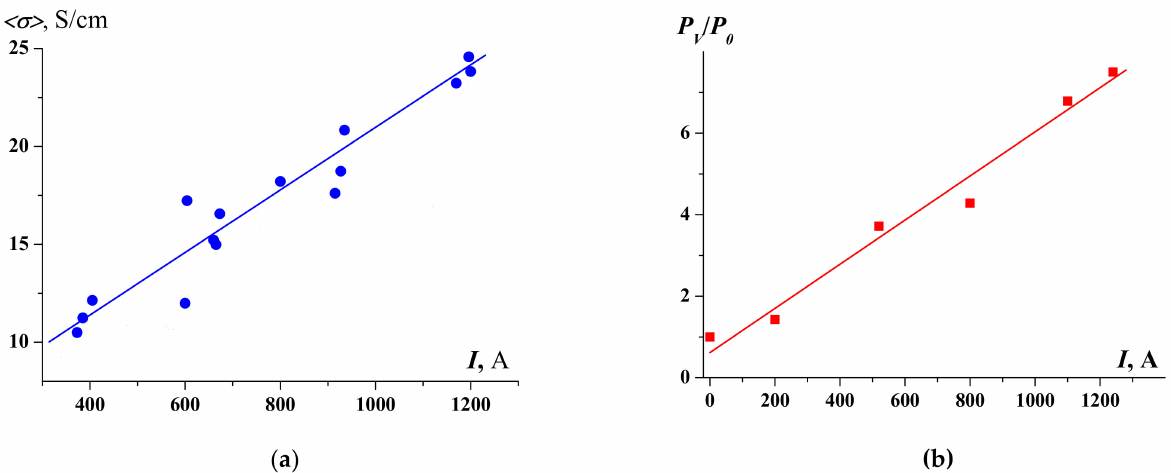
Figure 16. Dependence on the gas discharge current magnitude: ( a ) Gas discharge plasma conductiv- ity during surface discharge; ( b ) The value of relative pressure at the surface of the